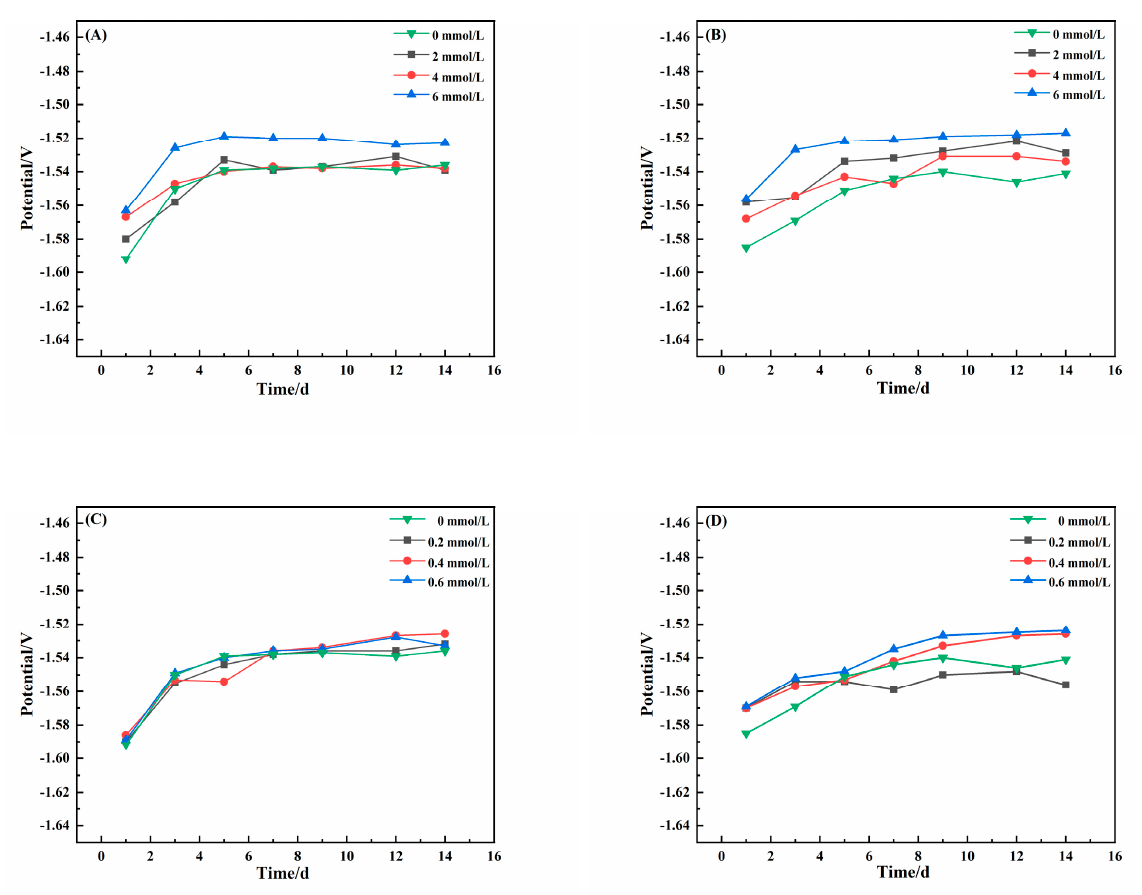
Figure 1. Open-circuit potential over time the magnesium alloys AZ31B ( A , C ) and AZ63B ( B , D ) in 3.5% NaCl solutions with different concentrations. Sulphide ( A , B ) and phosphate ( C , D ).